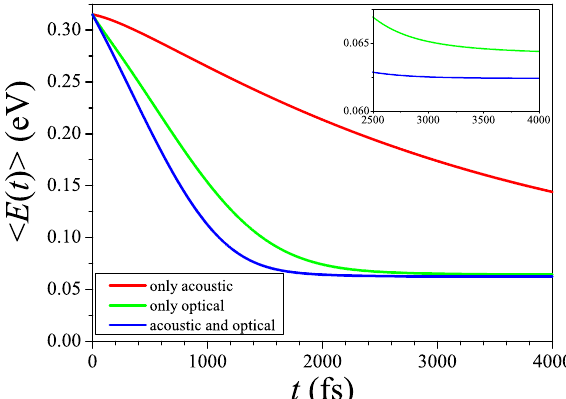
Figure 4. The time evolution of the mean energy is shown. “Only acoustic (optical)” represents the result, considering the time evolution only by the e-acoustic (ac) (op (optical))